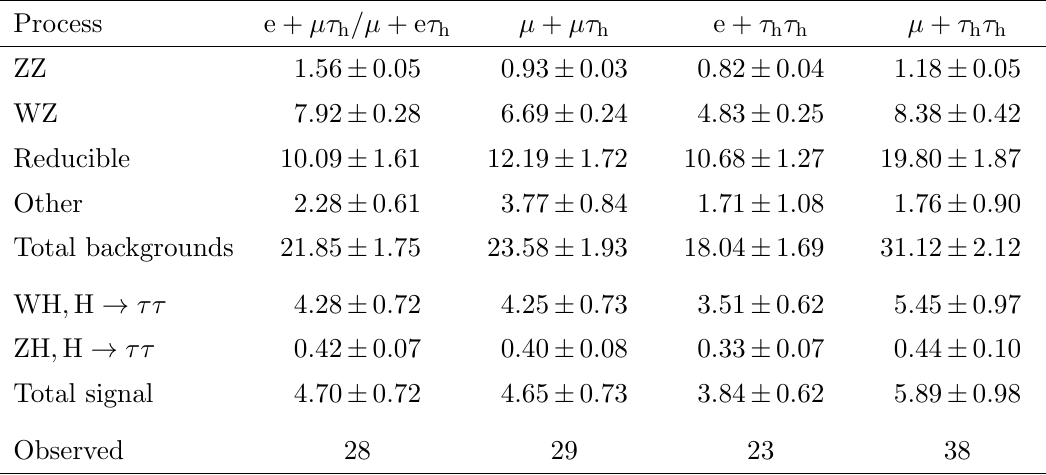
Table 4 . Background and signal expectations for the WH channels, together with the numbers of observed events, for the post-(cid:12)t signal region distributions. The WH and ZH, H ! (cid:28)(cid:28) signal yields are listed both individually and summed together, and correspond to H ! (cid:28)(cid:28) with a best (cid:12)t (cid:22) = 2 : 5 for a Higgs boson with a mass m H = 125 GeV. The background uncertainty accounts for all sources of background uncertainty, systematic as well as statistical, after the global (cid:12)t. The contributions from triboson, tt + W/Z, ttH production, and all production modes leading to H ! WW and H ! ZZ decays are included in the category labeled \Other".